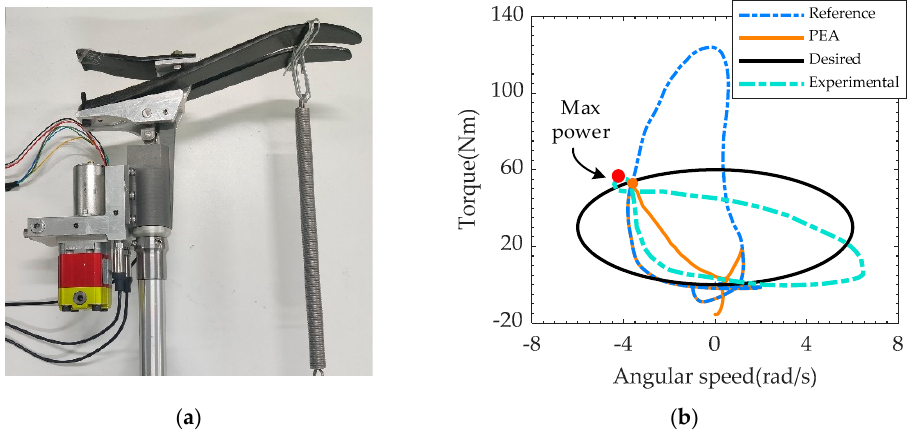
Figure 7. The loading test device and the load trajectory: ( a ) the experimental device of the loading test; ( b ) load trajectory expressed by angular speed and torque.